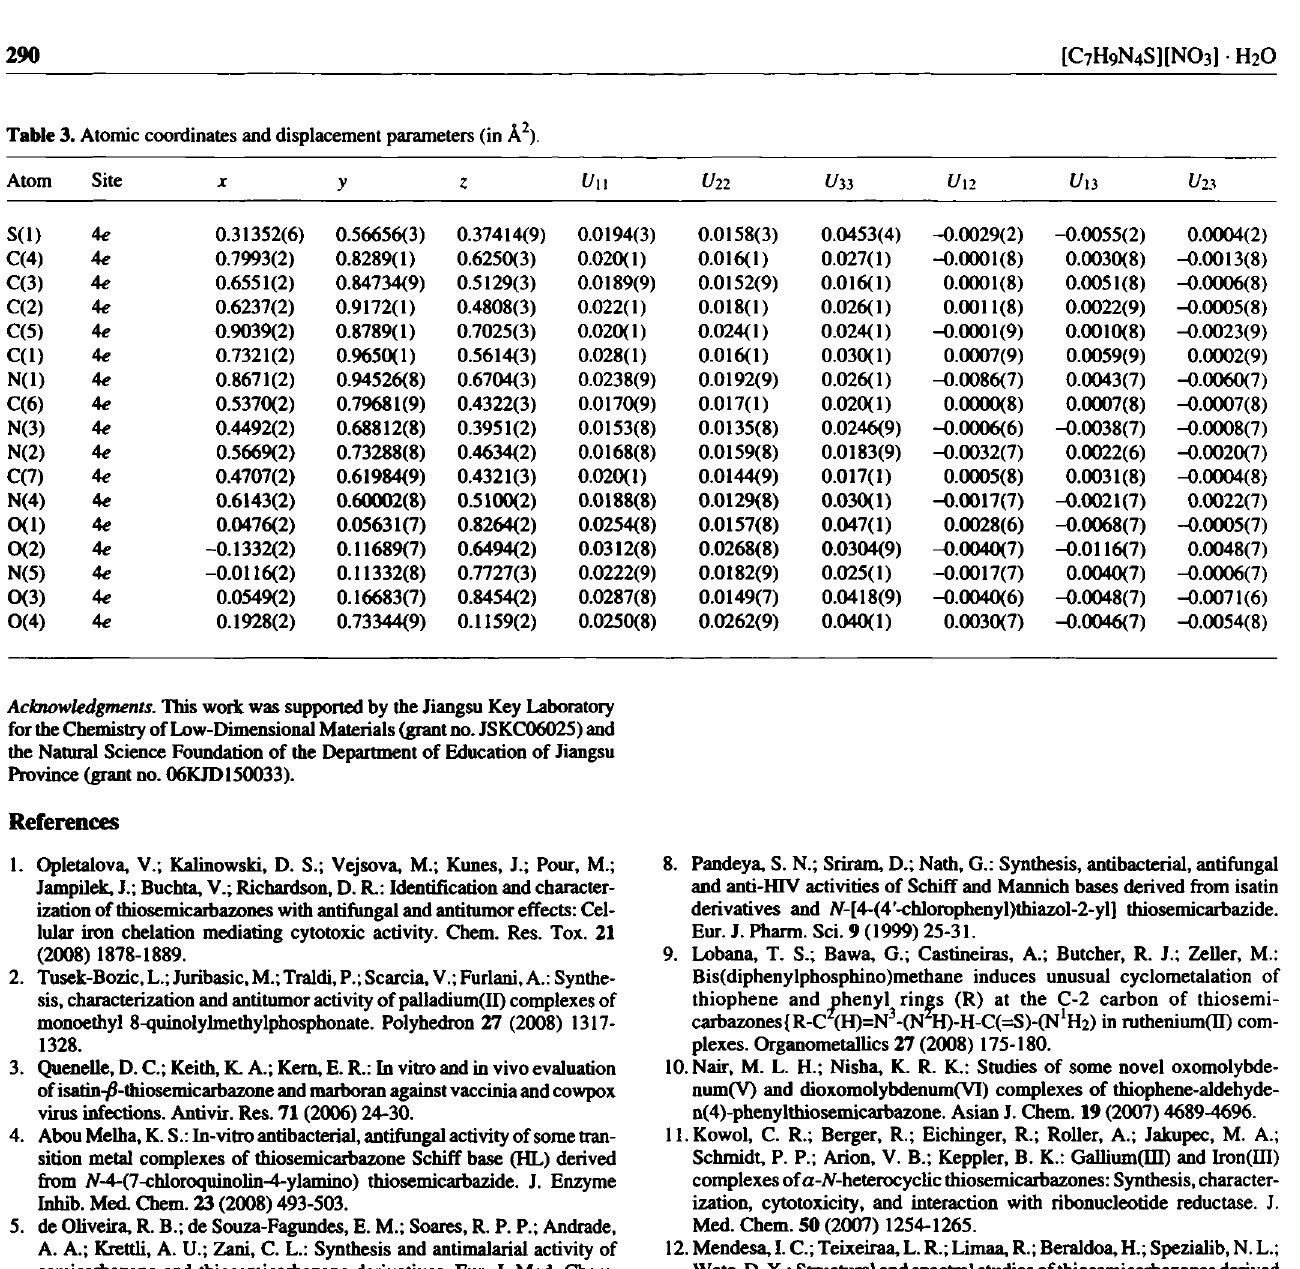
Table 3. Atomic coordinates and displacement parameters (in Â 2